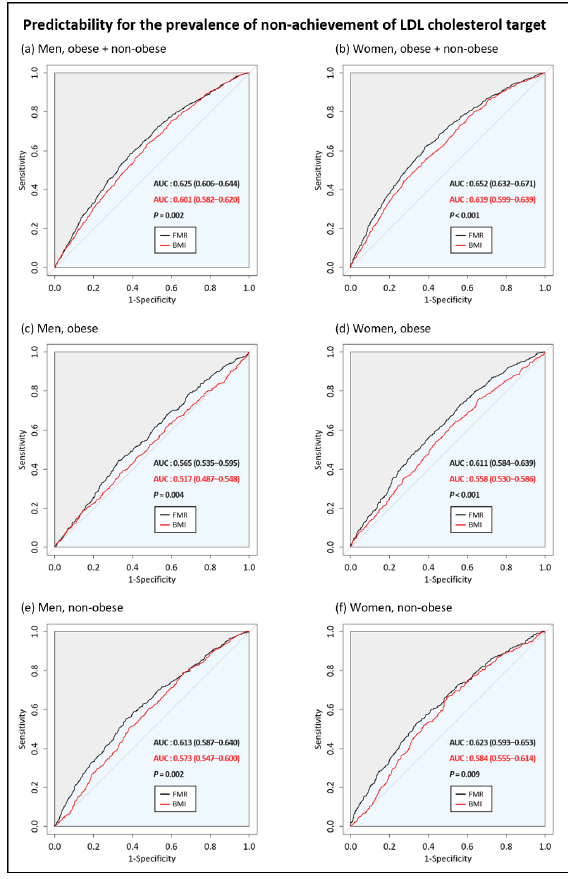
Figure 4. Comparison of the predictive powers of FMR and BMI for non-achievement of LDL cholesterol targets in ( a ) men, ( b ) women, ( c ) obese men, ( d ) obese women, ( e ) non-obese men, and ( f ) non-obese women. Abbreviations: FMR, fat-to-muscle ratio; BMI, body mass index; LDL, low-density lipoprotein.